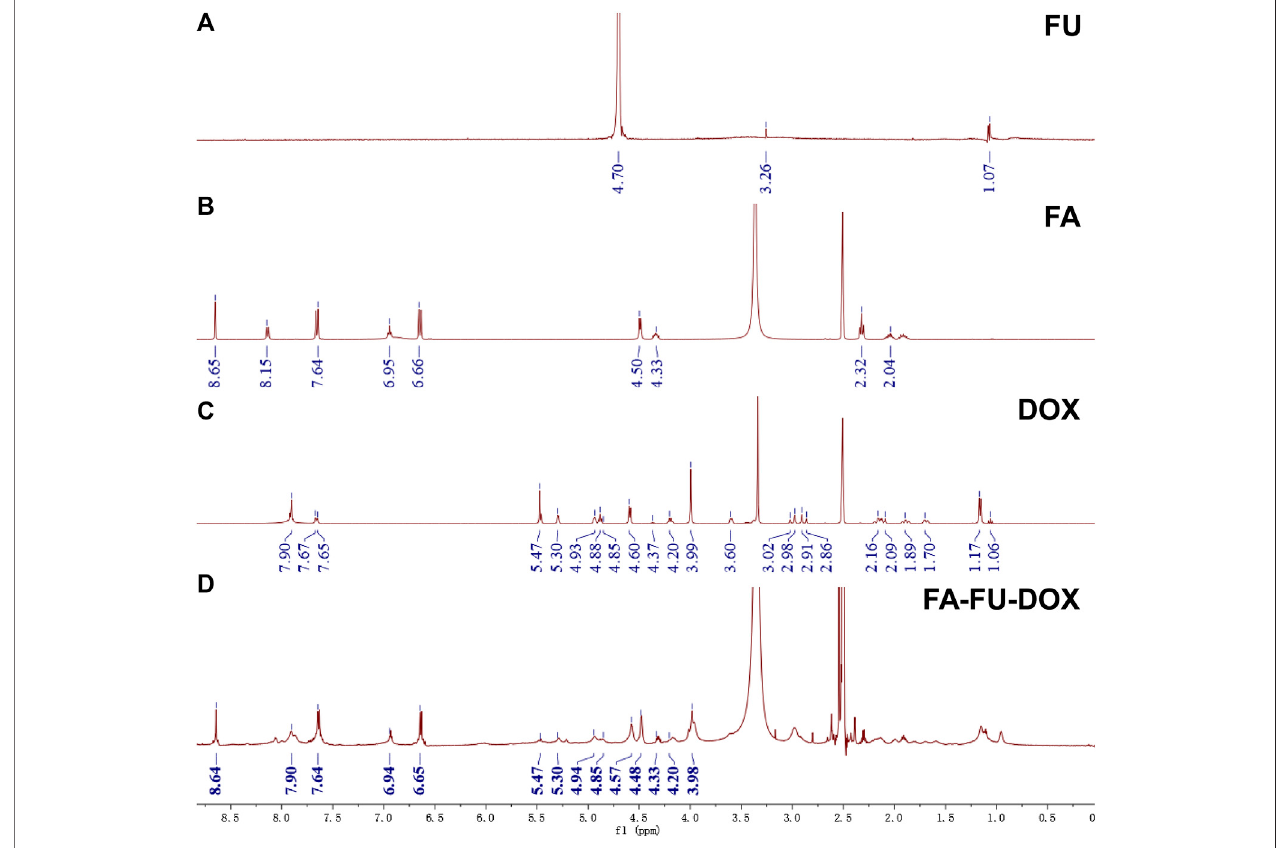
FIGURE 2 | The 1 H NMR spectra of (A) FU, (B) FA, (C) DOX, and (D) FA-FU-DOX.